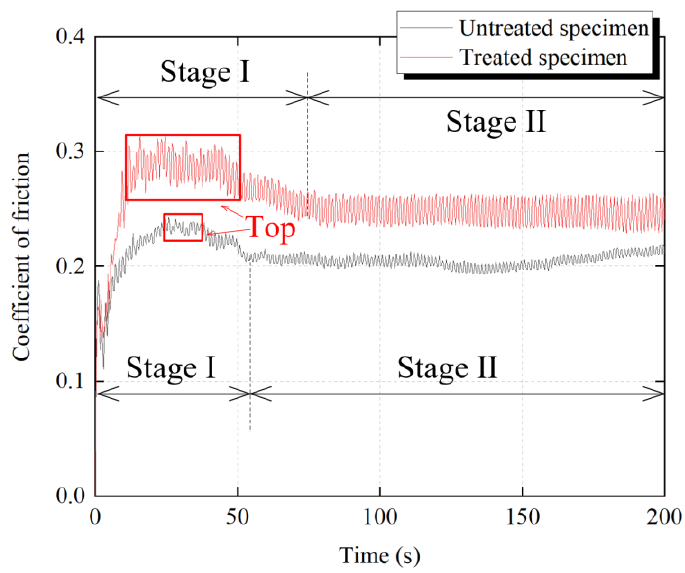
Figure 4. Coefficients of friction between the metal disc and untreated specimens and treated specimens.